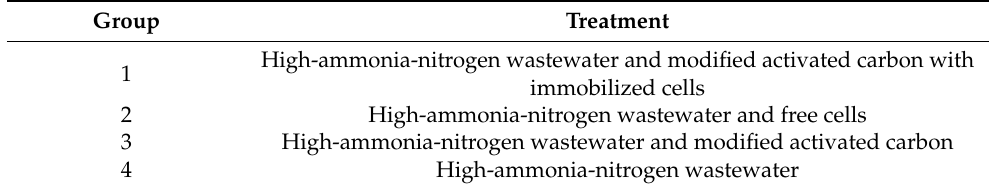
Table 2. Experimental grouping table of actual high-ammonia-nitrogen wastewater treatment